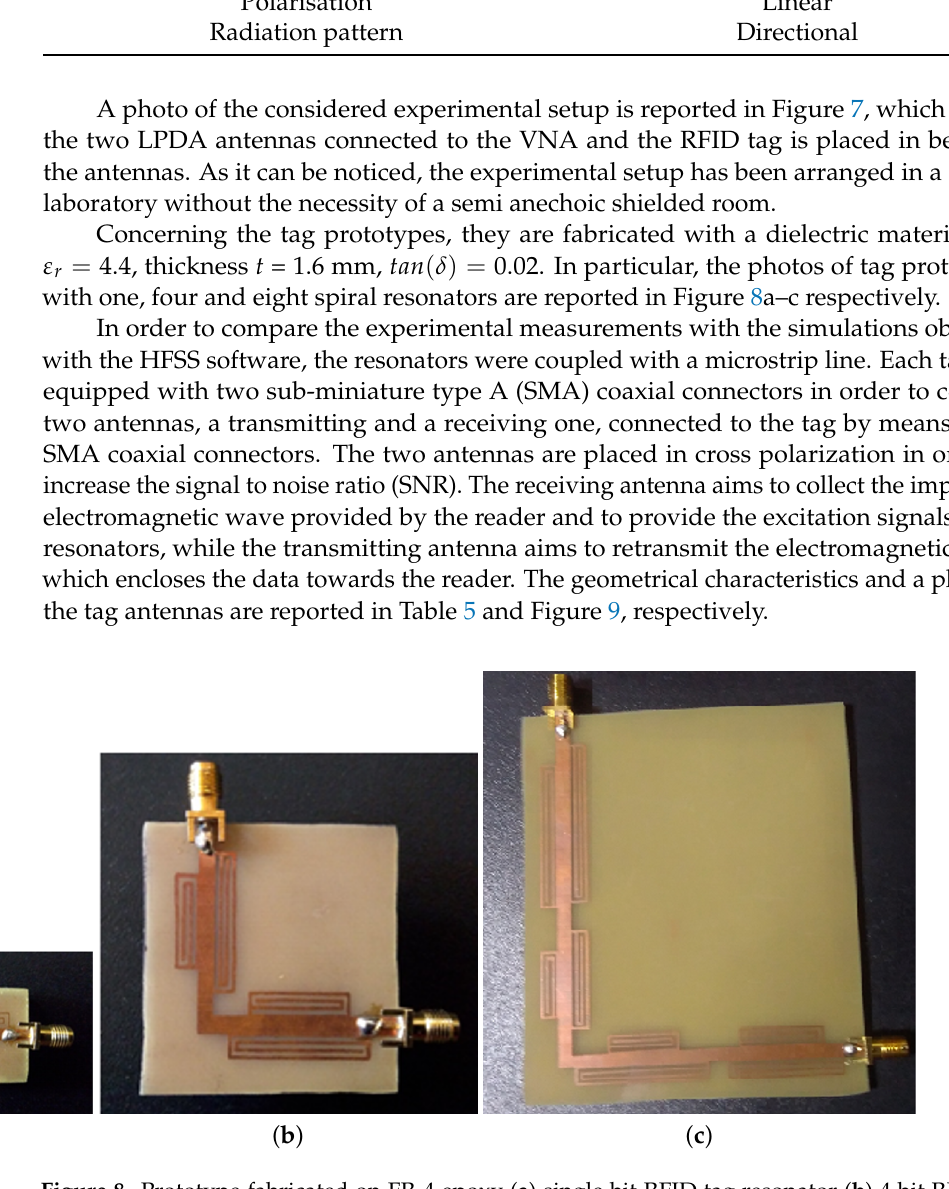
Figure 8. Prototype fabricated on FR-4 epoxy ( a ) single bit RFID tag resonator ( b ) 4 bit RFID tag ( c ) 8 bit RFID